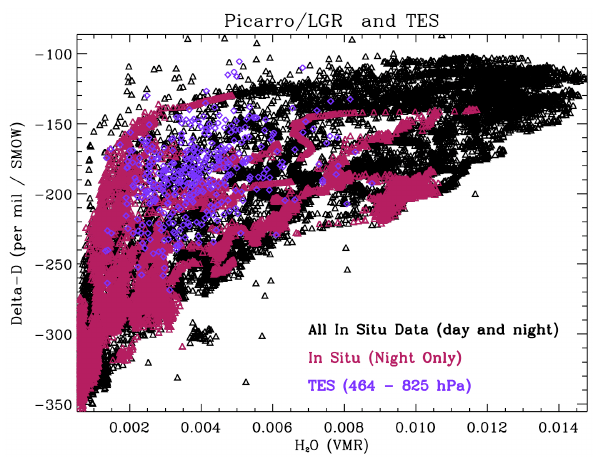
Fig. 2. (Black Diamonds) Distribution of δ -D versus H 2 O from the average of the Picarro and LGR data from 11 October through 5 November 2008. (Red) Night-time values for these same data. Figure 2: (Black Diamonds) Distribution of δ -D versus H 2 O from the average of the (Blue) TES column averages for all data within 1000km of Hawaii; Picarro and LGR data from October 11 through November 5 2008. (Red) Night-time the TES data have been corrected using a bias correction factor of values for these same data. (Blue) TES column averages for all data within 1000 km of 0.05, modified by the averaging Hawaii; the TES data have been corrected using a bias correction factor of 0.05, modified by the averaging kernel.